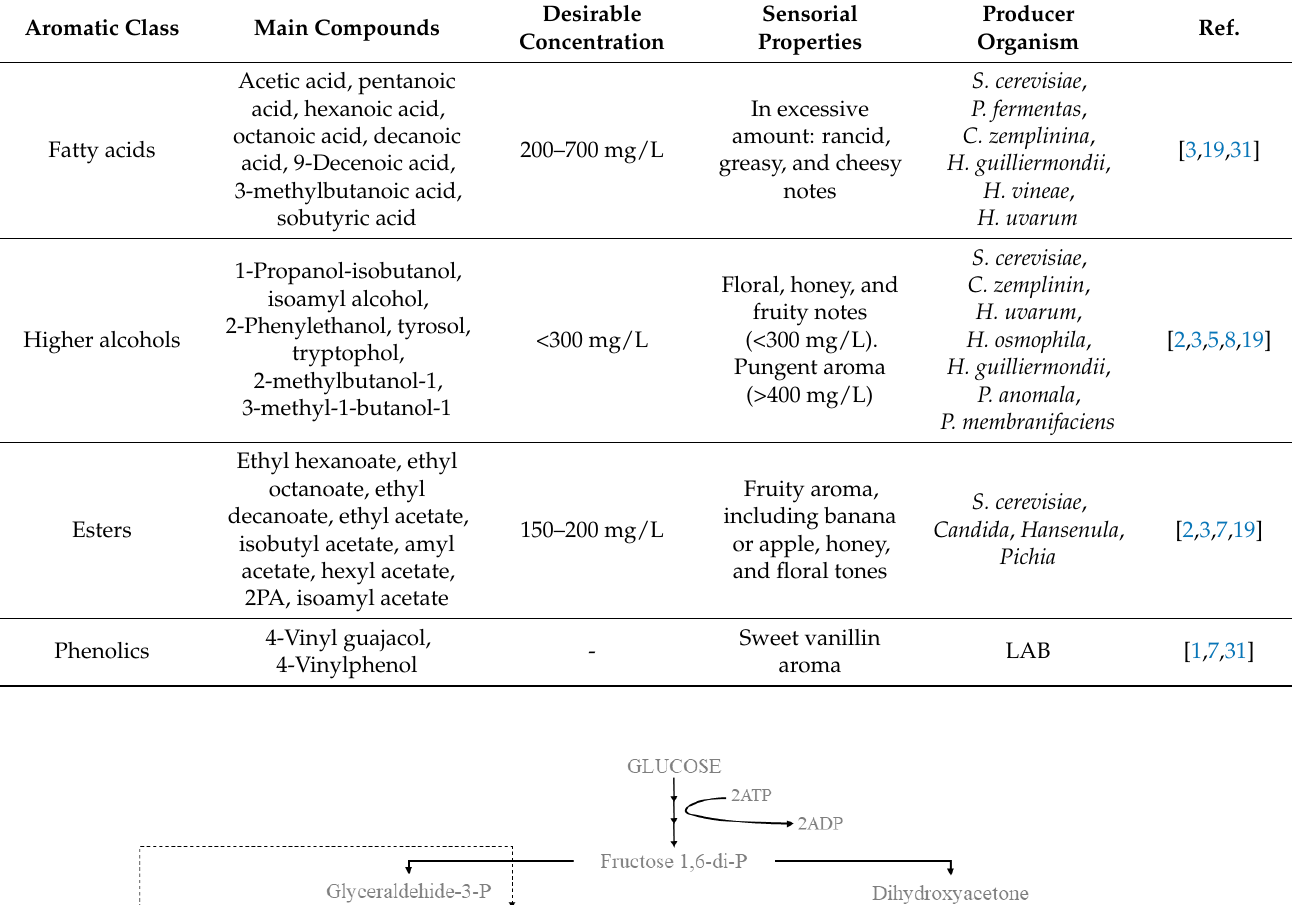
Table 1. Compounds involved in secondary aroma, classes of volatile aroma, main representative, desirable concentration, sensorial properties and producer microorganisms. Aromatic Class Main Compounds